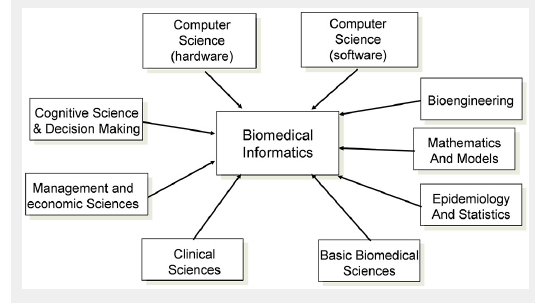
Biomedical informatics is a field of science at the intersection of other domains and is interdisciplinary by essence [1].